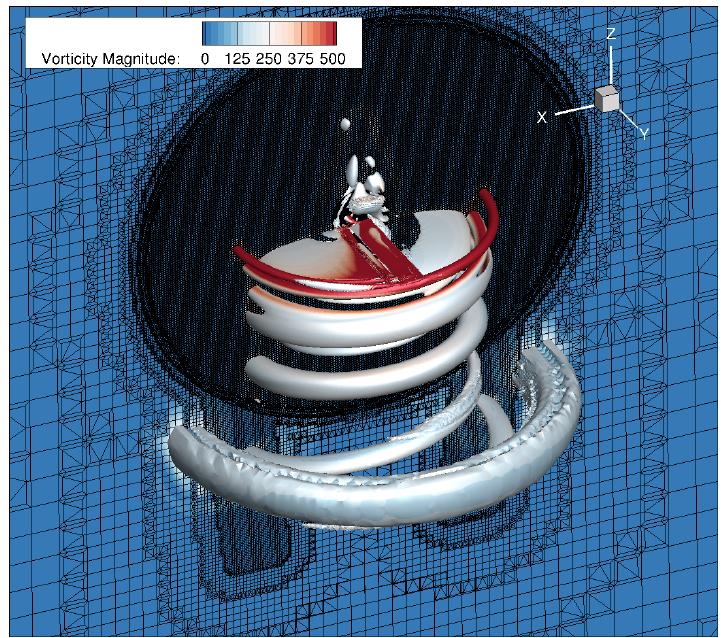
Figure A6. Iso-surface of Q -criterion ( Q = 5000 s − 2 ) contoured with vorticity magnitude and super- positioning on y-sliced